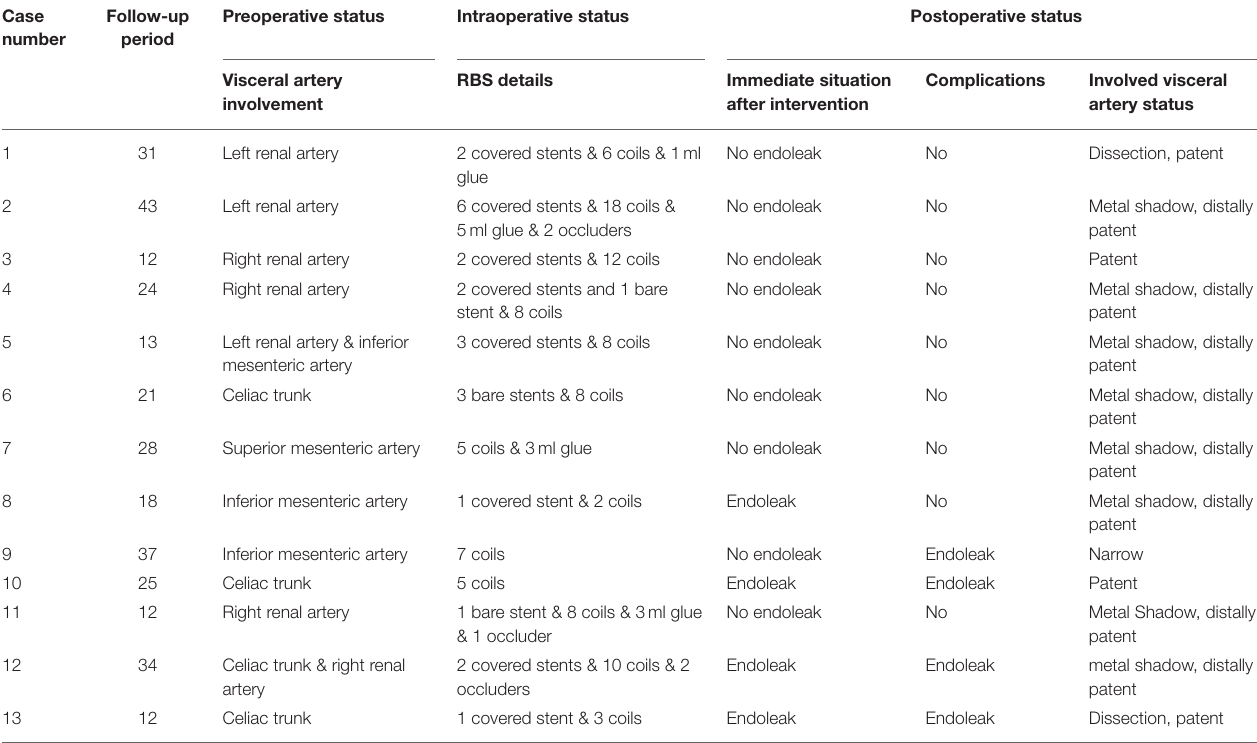
TABLE 2 | RBS details in all